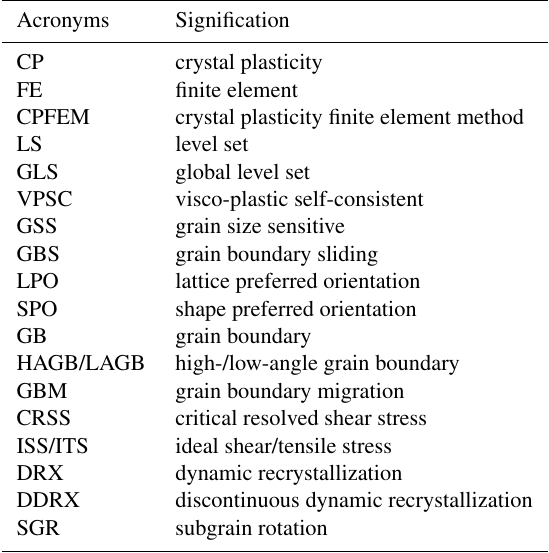
Table 1. List of the acronyms used in this